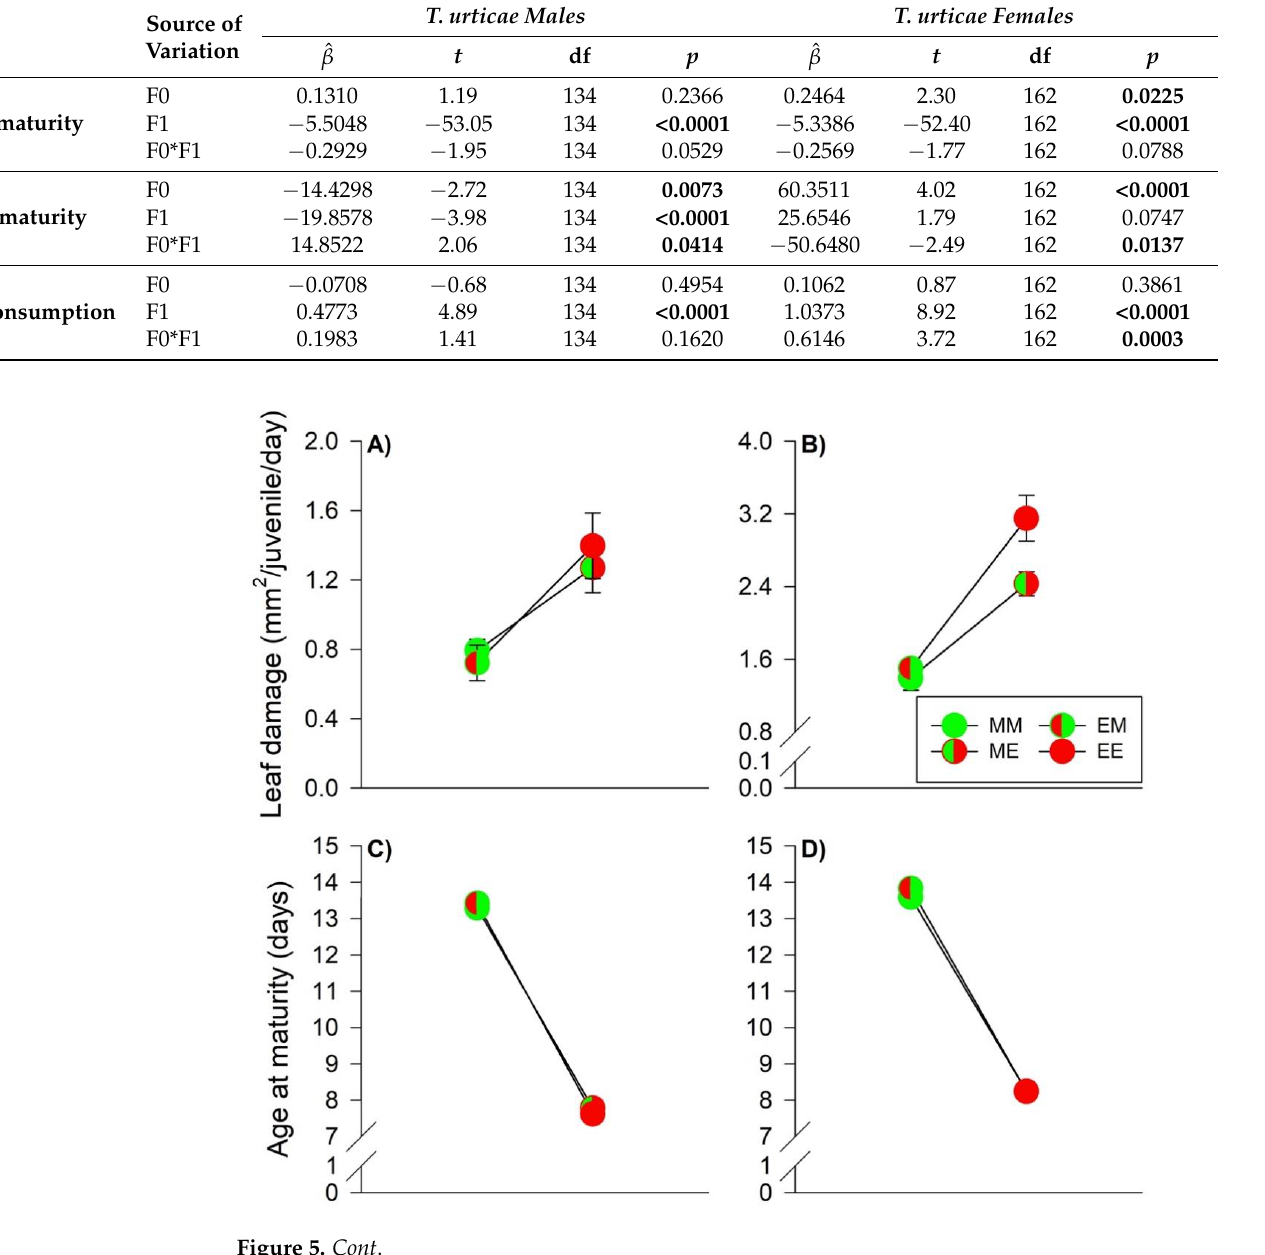
Figure 5. Heat wave effects during juvenile development on the leaf damage, age at maturity, and size at maturity of males ( A , C , E ) and females ( B , D , F ) of the prey T. urticae . The circles illustrate the